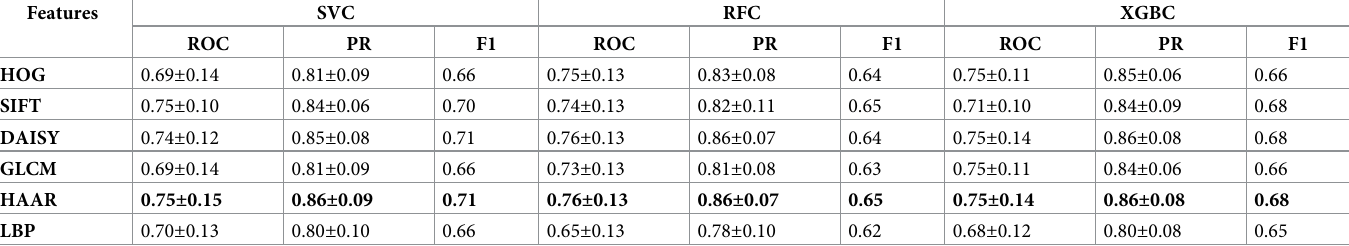
ROC (Area under the ROC curve), PR (Area under the precision-recall curve), F1 (F1 Score), SVC (Support Vector classifier), RF (Random Forest classifier), XGBC (XGBoost classifier). Bold-faced values indicate the best performance for each model.